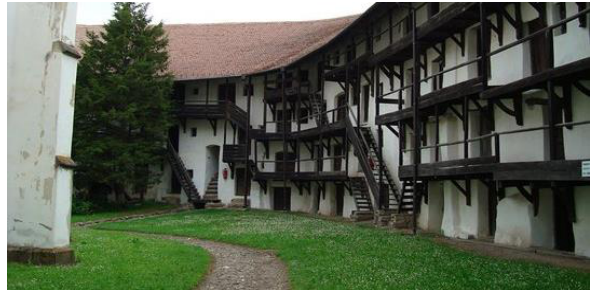
Figure 6. Details of Prejmer fortified church.